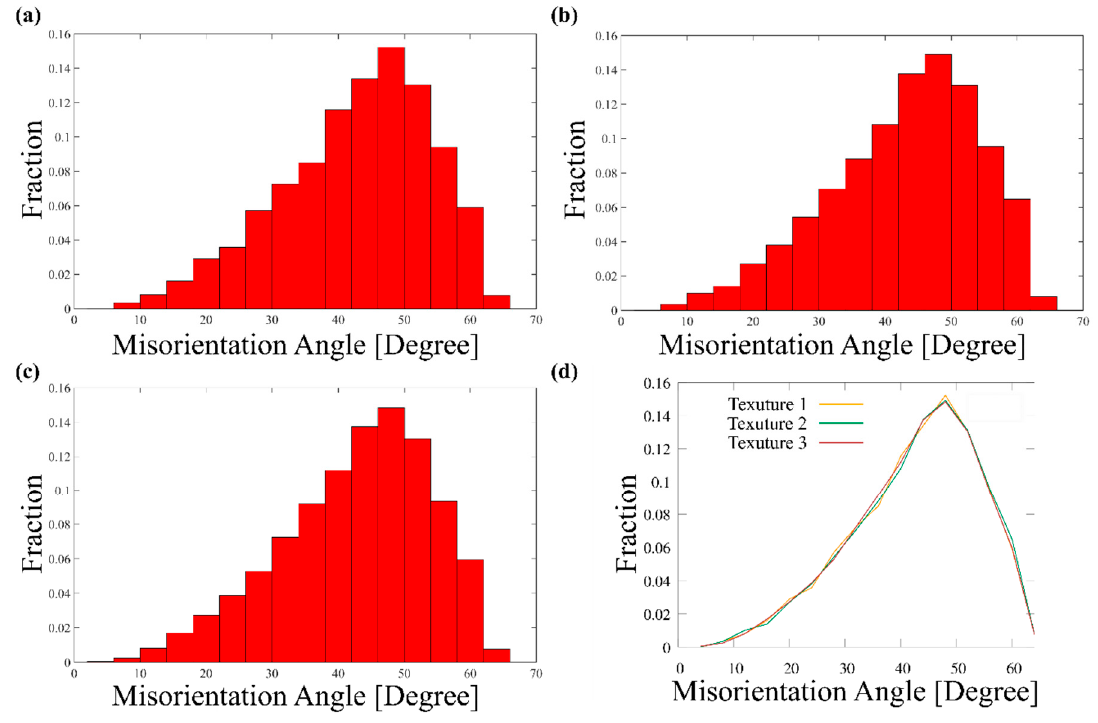
Figure A1. Effect of initial texture on distribution of misorientation angle ( a ) texture 1; ( b ) texture 2; ( c ) texture 3; ( d ) all combined .